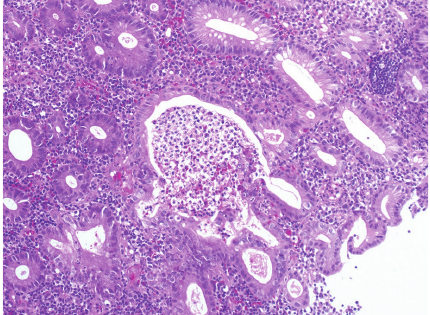
Figure 1: CT scan of a 36-year-old man with RP. The nasal septum is edematous and inflamed. CT, computed tomography; RP, relapsing polychondritis.